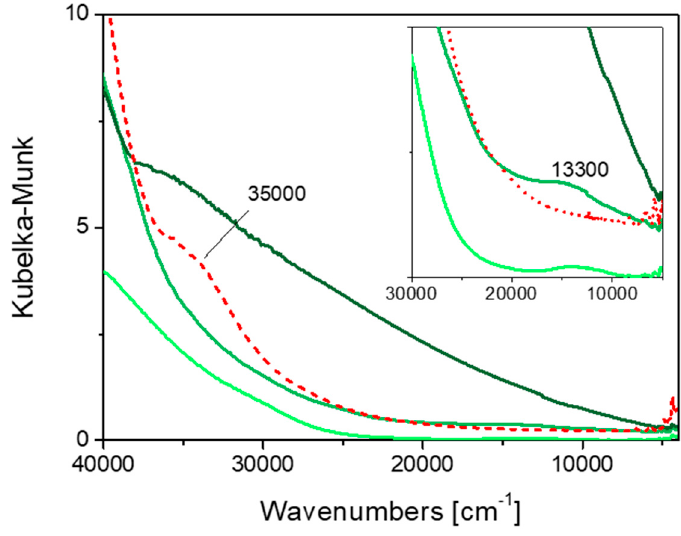
Figure 2. DR UV-Vis_NIR spectra of as-prepared Cu/C β CAT (light green line), as prepared PdCu/C β CAT (green line) and of PdCu/C β CAT after reaction (dark green line). The spectrum of crosslinked β CD (red dashed line) is also reported for comparison. Inset: Spectra shown in the 30,000 to 5000 cm − 1 range.